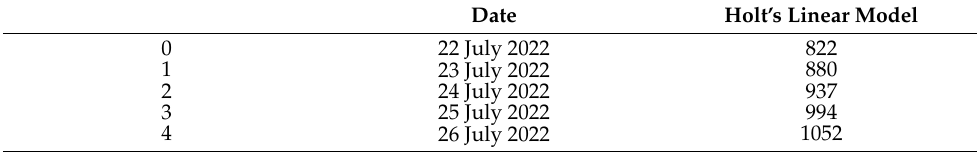
Table 3. Holt’s linear model confirmed case prediction over five days.